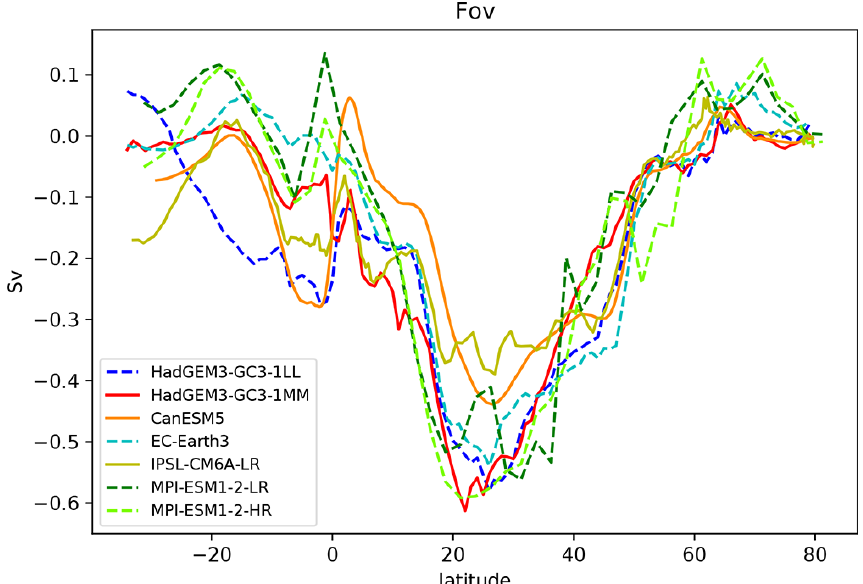
Figure 9. Values of Fov (the freshwater transport by the AMOC in the Atlantic; Sv) by latitude for the control experiments. Different colours indicate different models, and solid (dashed) lines indicate those models which have (do not have) experiments where the AMOC stays weak after hosing